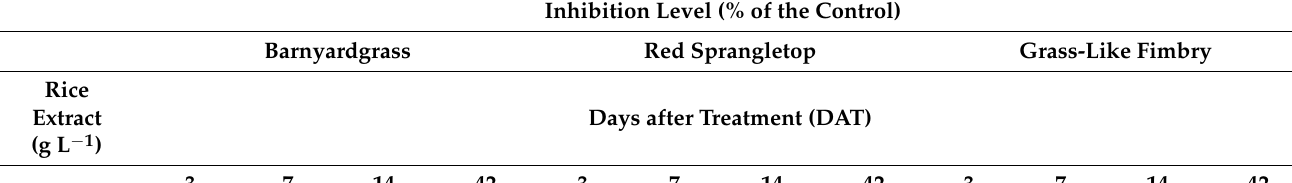
Table 3. Effect of OM 5930 rice extract on the survival of barnyardgrass, red sprangletop, and grass-like fimbry seedlings from 3 to 42 days after